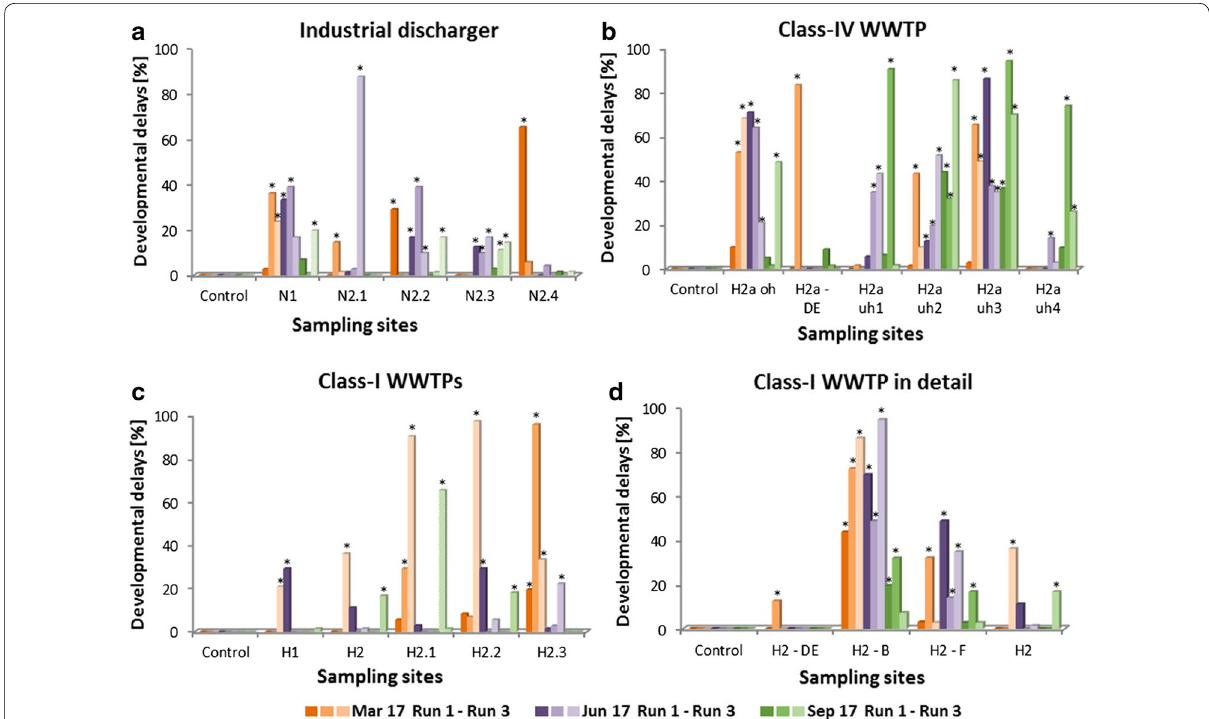
Fig. 3 Developmental delays at 24 hpf for the additional sampling sites. Plot a shows results from upstream (N1) and downstream (N2.1–N2.4) of the industrial discharger at River Nidda. Plot b depicts results from upstream of (H2a oh), downstream of (H2a uh1–uh4) and directly from the efflux pipe (H2a‑DE) of a class‑IV WWTP at River Horloff. Plots c and d illustrate results from upstream (H1) and downstream (H2–H2.3) of the class‑I WWTPs ( c ) and a more detailed resolution of the last class‑I WWTP ( d ). Asterisks mark significant differences to control treatments; Likelihood ratio χ 2 , Fisher’s exact test ( p < 0.05), correction with sequential Bonferroni–Holm method p <